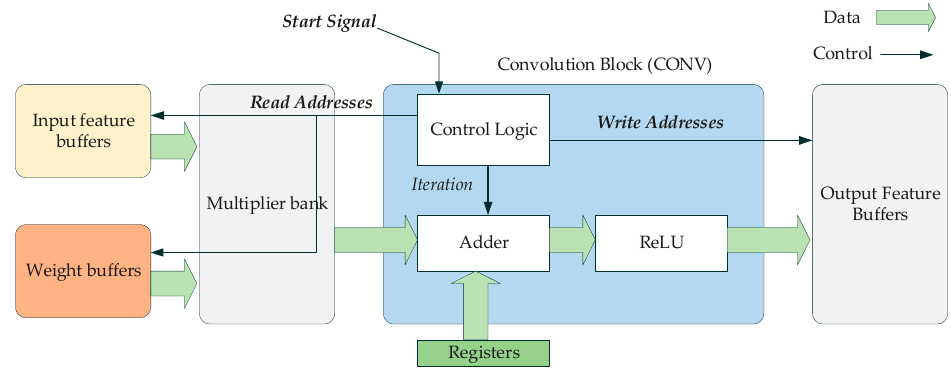
Figure 5. The schematic of a convolutional block within an FPGA.